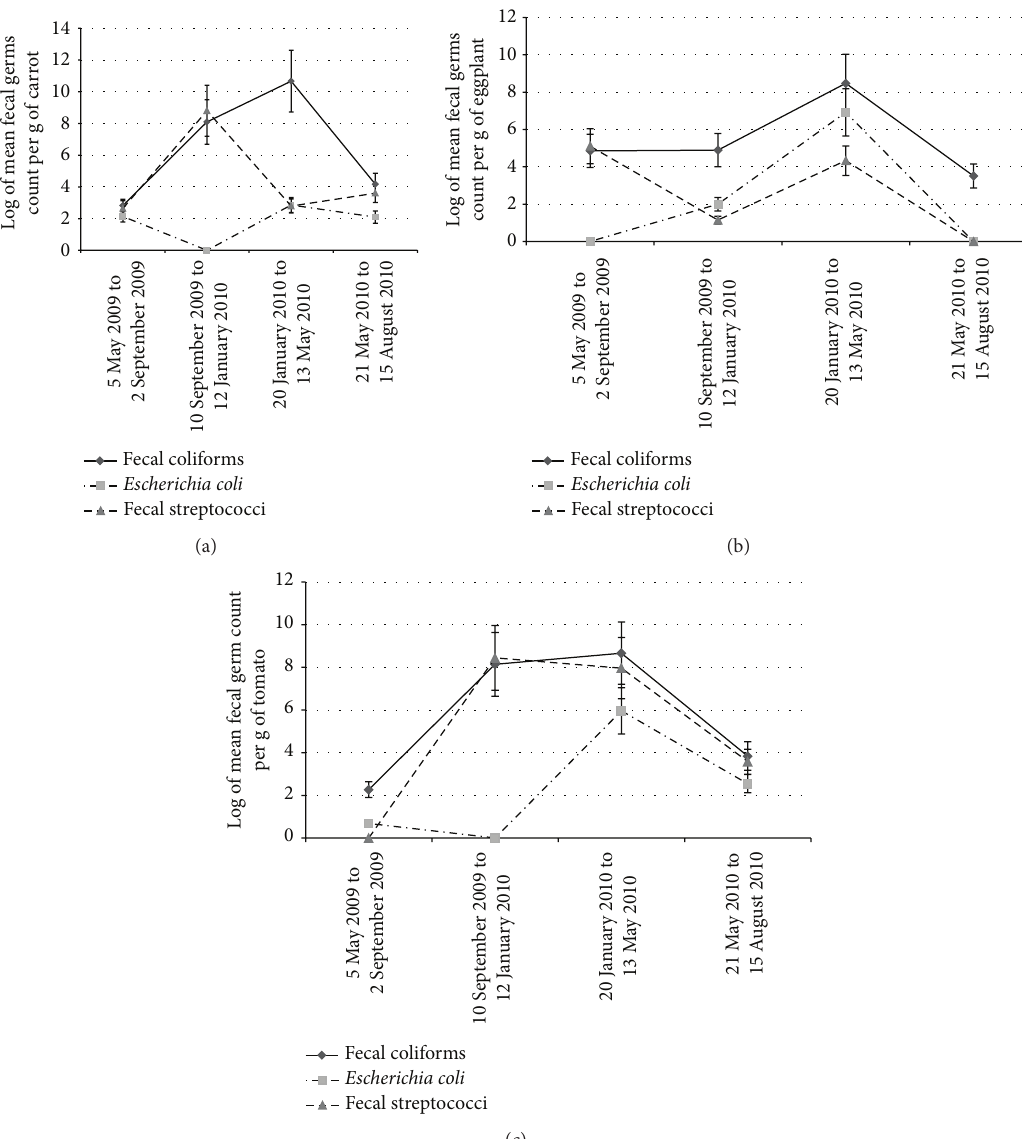
Figure 2: (a) Changes in populations of fecal bacteria on carrot per growing period (sites and fertilization treatments considered together (coastal area of Benin, 2009-2010, 288 plots, 32 samples)). (b) Changes in populations of fecal bacteria on eggplant per growing period (sites and fertilization treatments considered together (coastal area of Benin, 2009-2010, 288 plots, 32 samples)). (c) Changes in populations of fecal bacteria on tomato per growing period (sites and fertilization treatments considered together (coastal area of Benin, 2009-2010, 288 plots, 32 samples)).